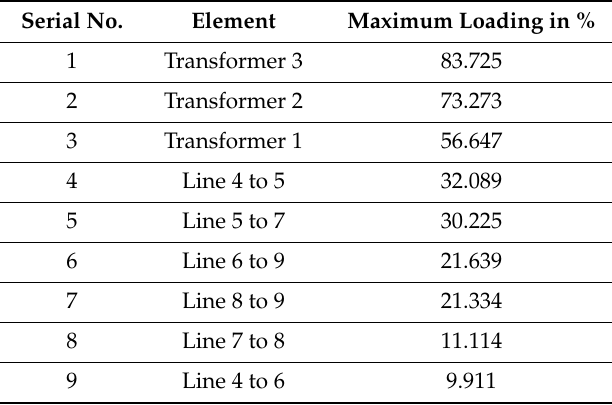
Table 4. Quasi-dynamic simulation report (loading range).